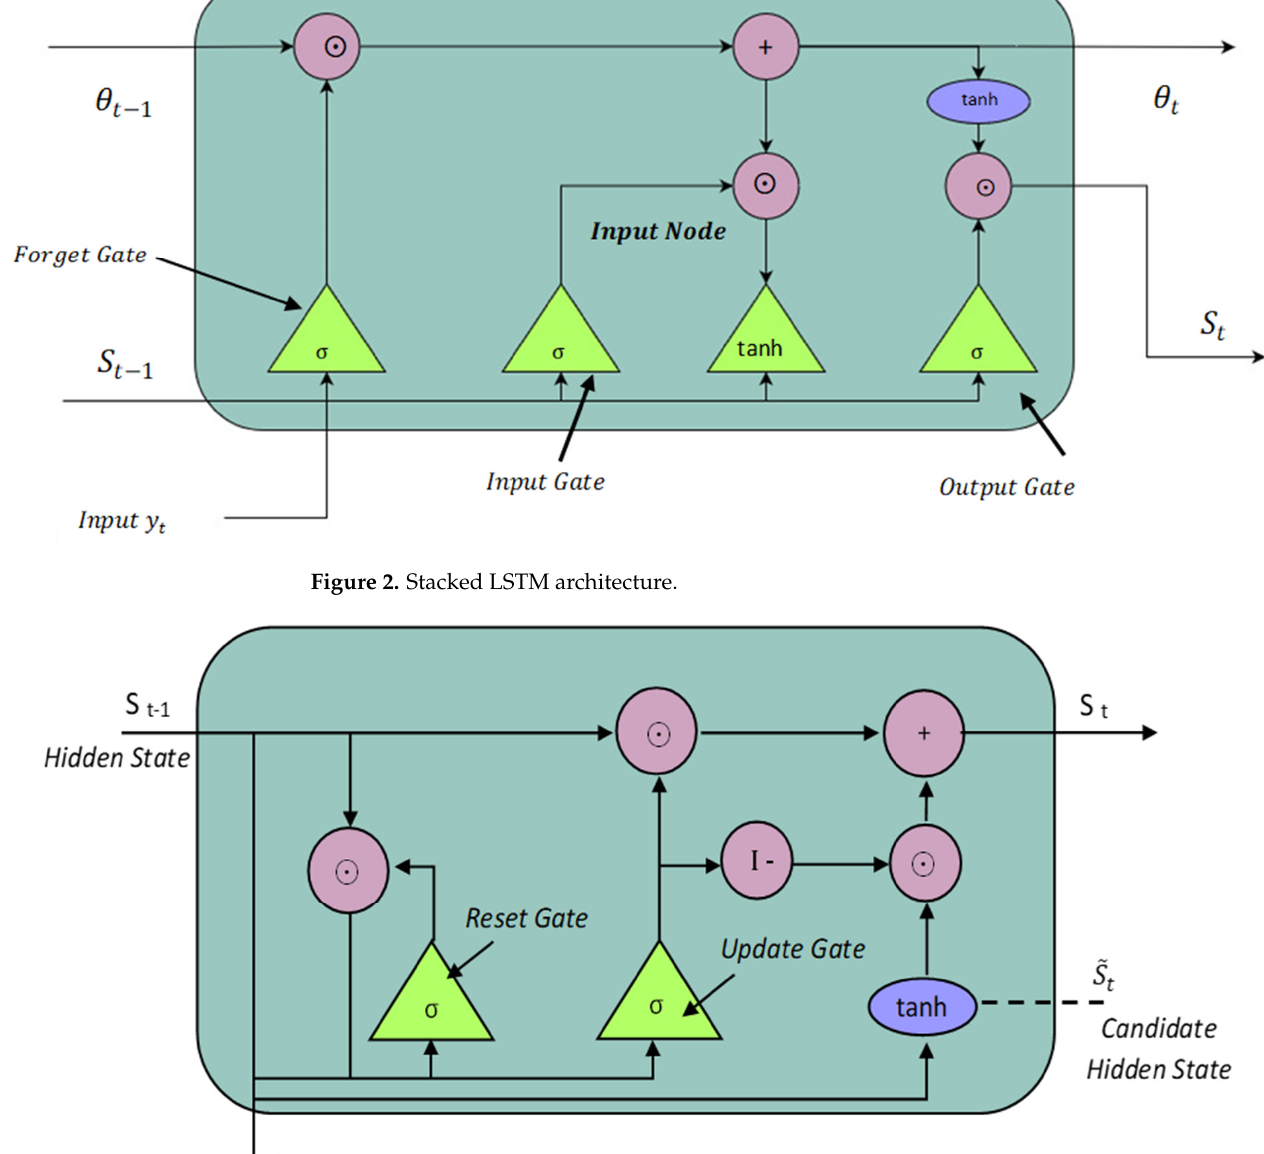
Figure 2. Stacked LSTM architecture.